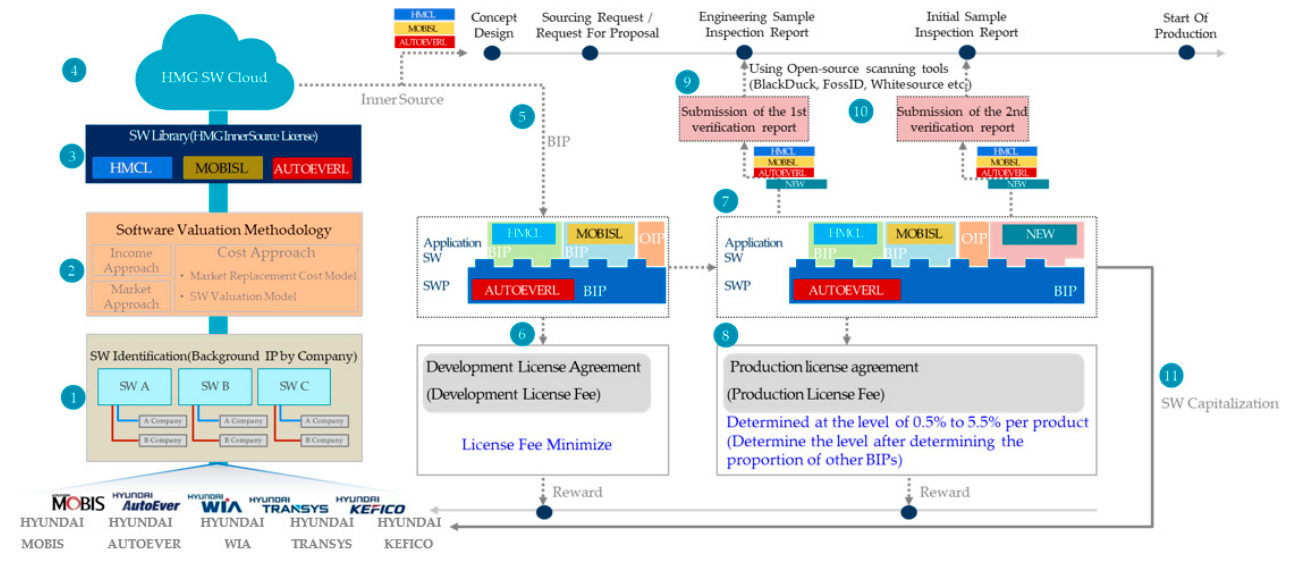
Figure 12. Example of SW Joint Development.